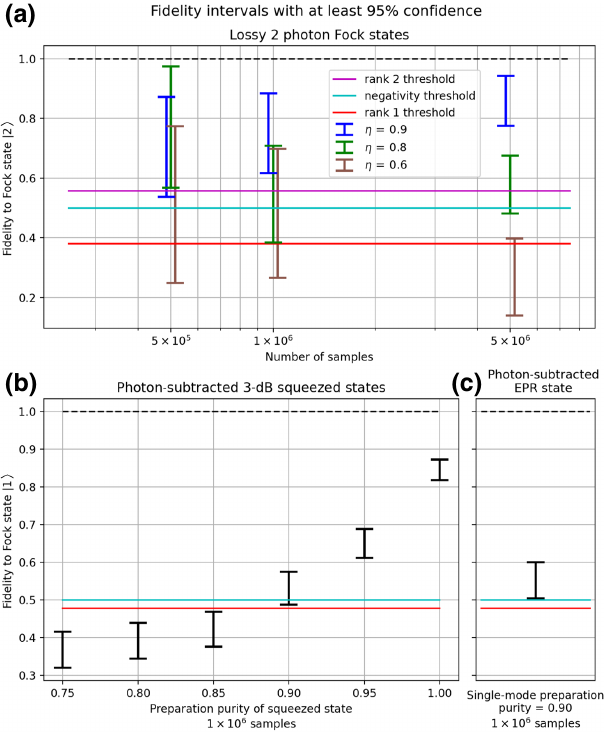
FIG. 4. Estimation of fidelity with target Fock states at 95% confidence, using simulated samples from double homodyne detection of various states. When the lowest point of an error bar is higher than a threshold value, the property corresponding to this threshold value is certified with more than 95% confidence. The precision of the estimate varies depending on the number of samples used. We display the stellar rank 1 (respectively, 2) threshold in red (respectively, purple) and the Wigner negativ- ity witness threshold (see Sec. IV) in cyan. Note that the rank-1 threshold varies depending on whether the target state is the Fock state | 1 (cid:3) or | 2 (cid:3) , as can be checked with Fig. 3. (a) Lossy two- photon Fock states ( 1 − η) 2 | 0 (cid:3)(cid:2) 0 | + 2 η( 1 − η) | 1 (cid:3)(cid:2) 1 | + η 2 | 2 (cid:3)(cid:2) 2 | , where η is an efficiency parameter, and target Fock state | 2 (cid:3) . For η = 0.9, 0.8, and 0.6, the true fidelities to | 2 (cid:3) are 0.81, 0.64, and 0.36, respectively. The Wigner-negativity threshold is obtained numerically [40]. (b) Photon-subtracted squeezed vacuum states with 3 dB of squeezing and target Fock state | 1 (cid:3) , for several values of the preparation purity, i.e., the purity of the squeezed vacuum state before the photon subtraction. (c) A photon sub- tracted two-mode EPR state with experimental covariance matrix taken from Ref. [41] and target Fock state | 1 (cid:3) . Simulated pho- ton subtraction is done on the first mode and double homodyne measurement on the second mode of the EPR state.